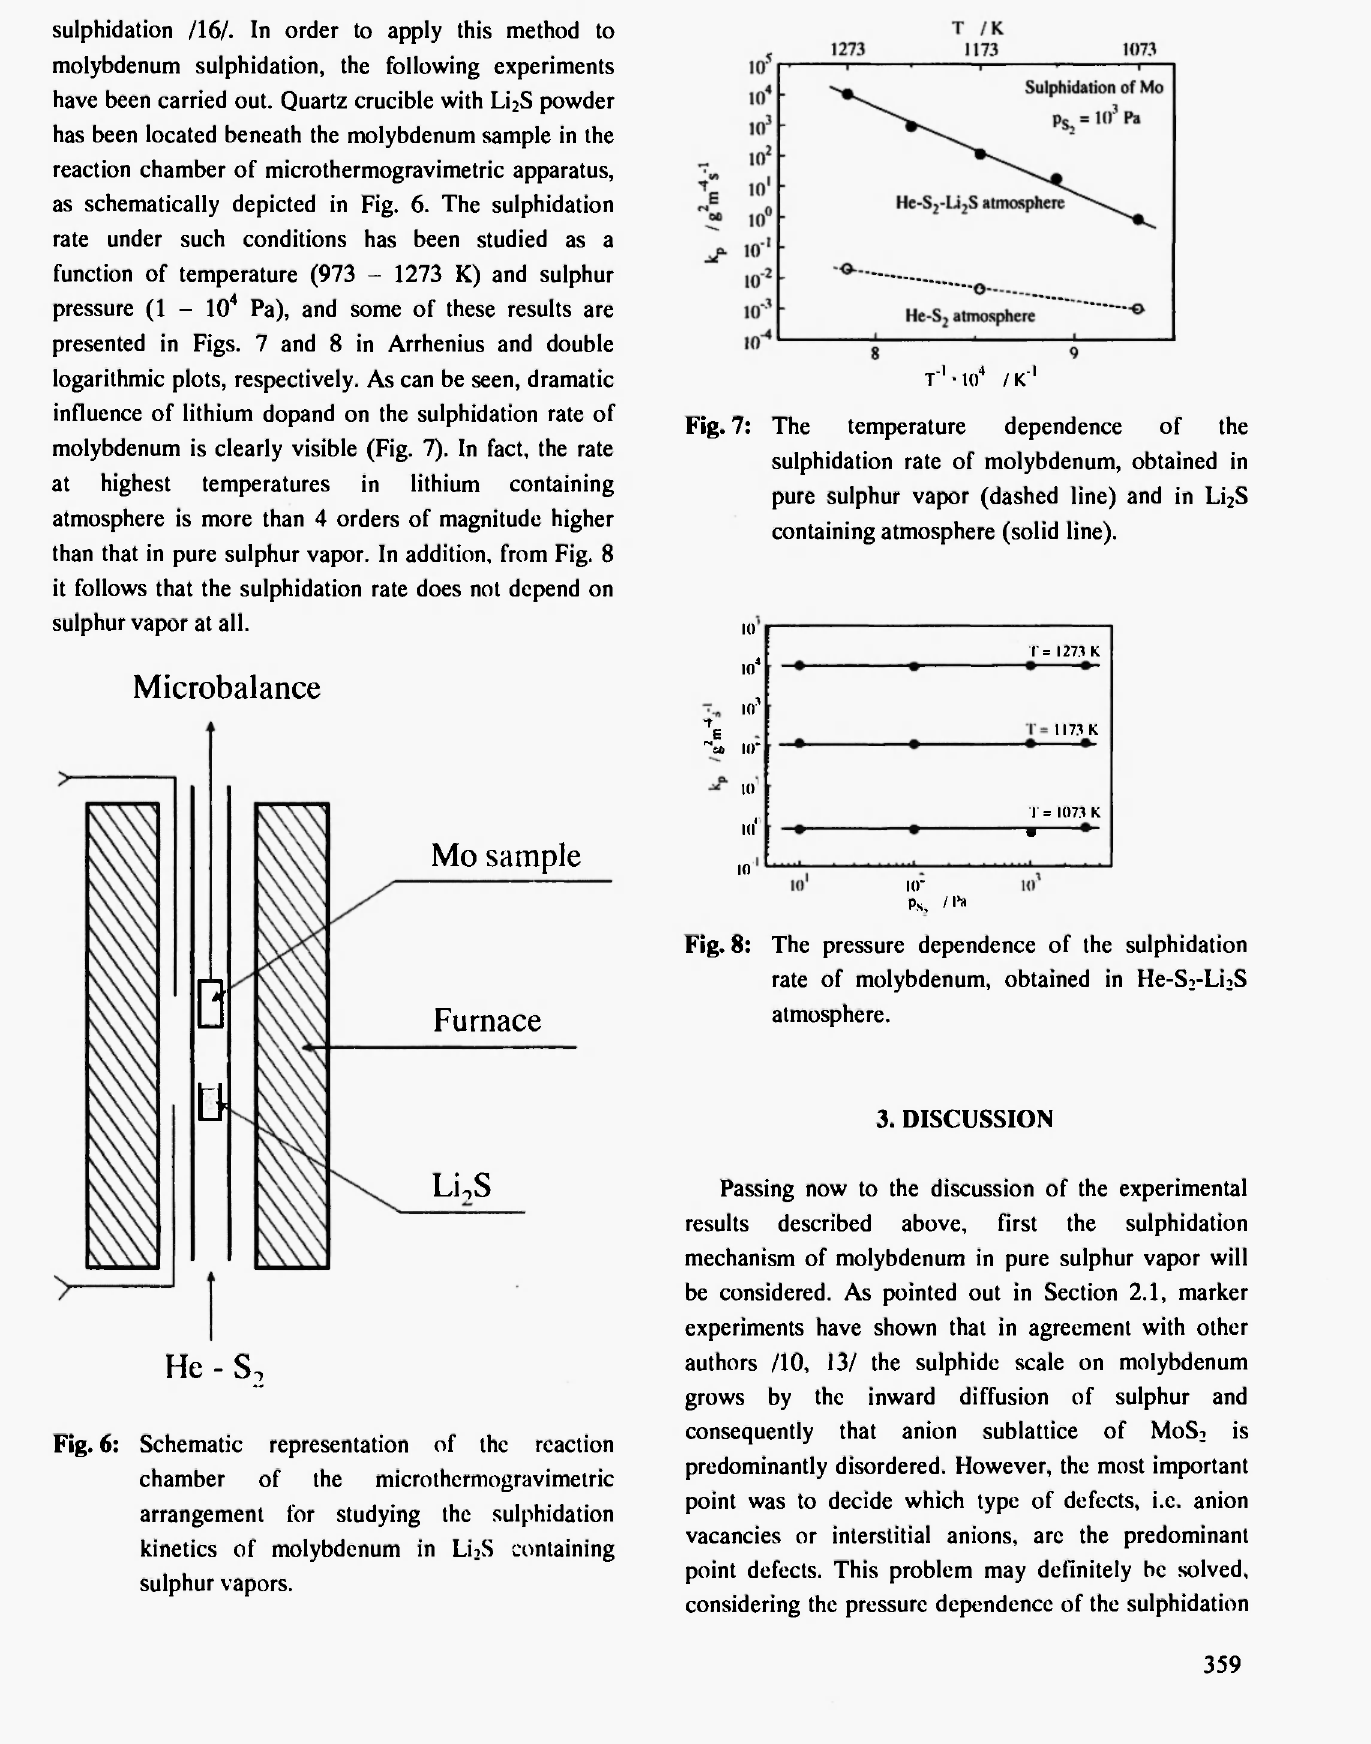
Fig. 7: The temperature dependence of the sulphidation rate of molybdenum, obtained in pure sulphur vapor (dashed line) and in Li 2 S containing atmosphere (solid line).